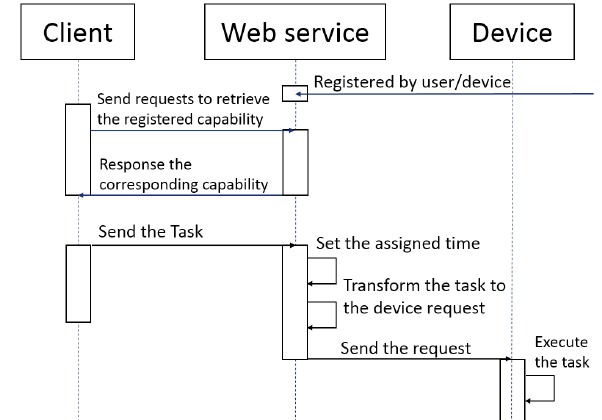
Figure 4. The sequence diagram of proposed web